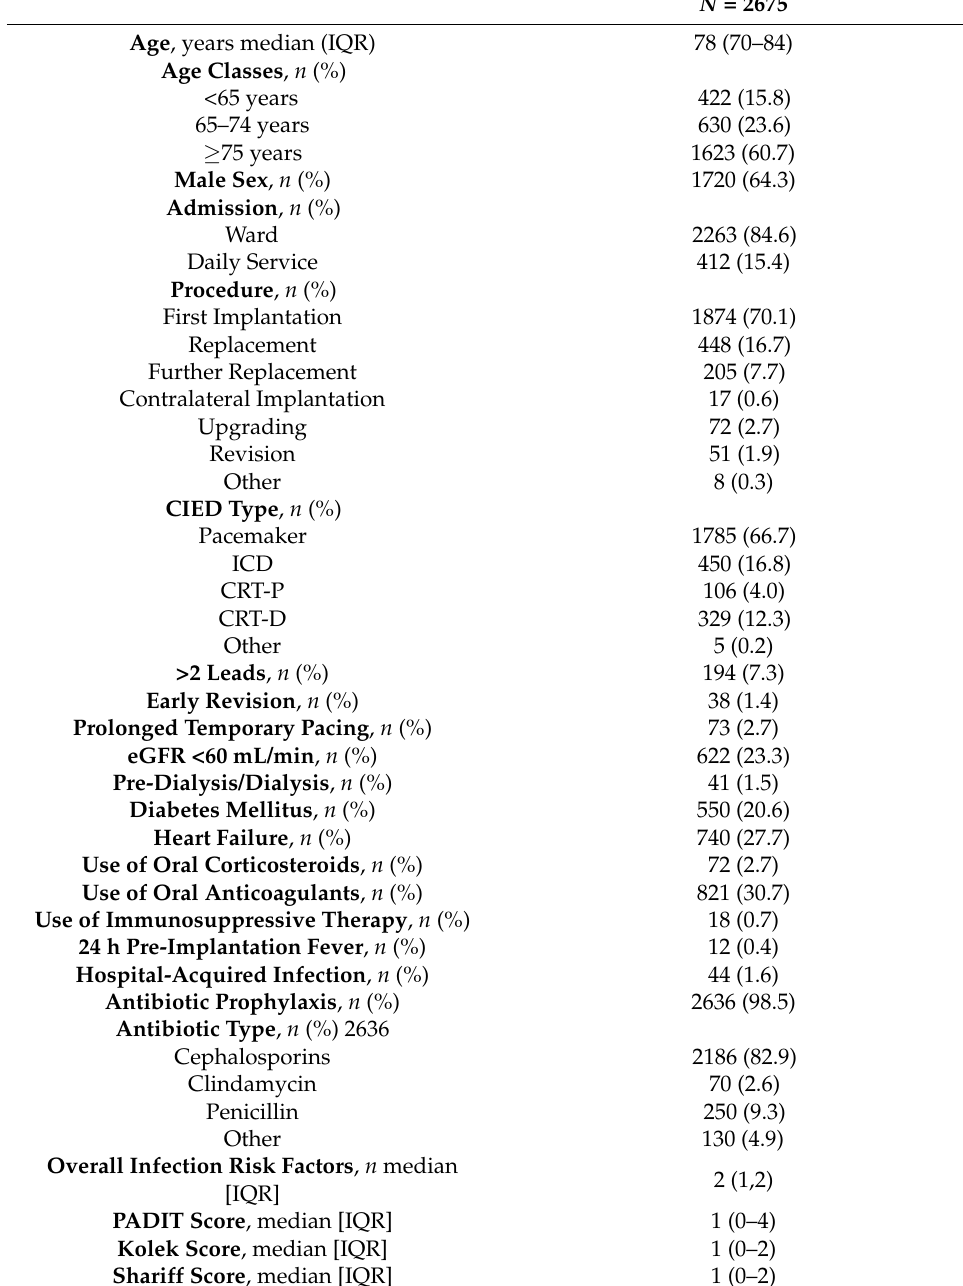
Table 1. Baseline characteristics of enrolled